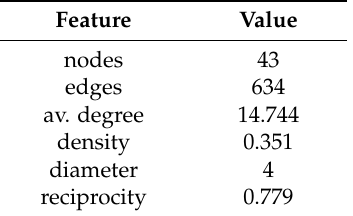
Table 2. The main features of